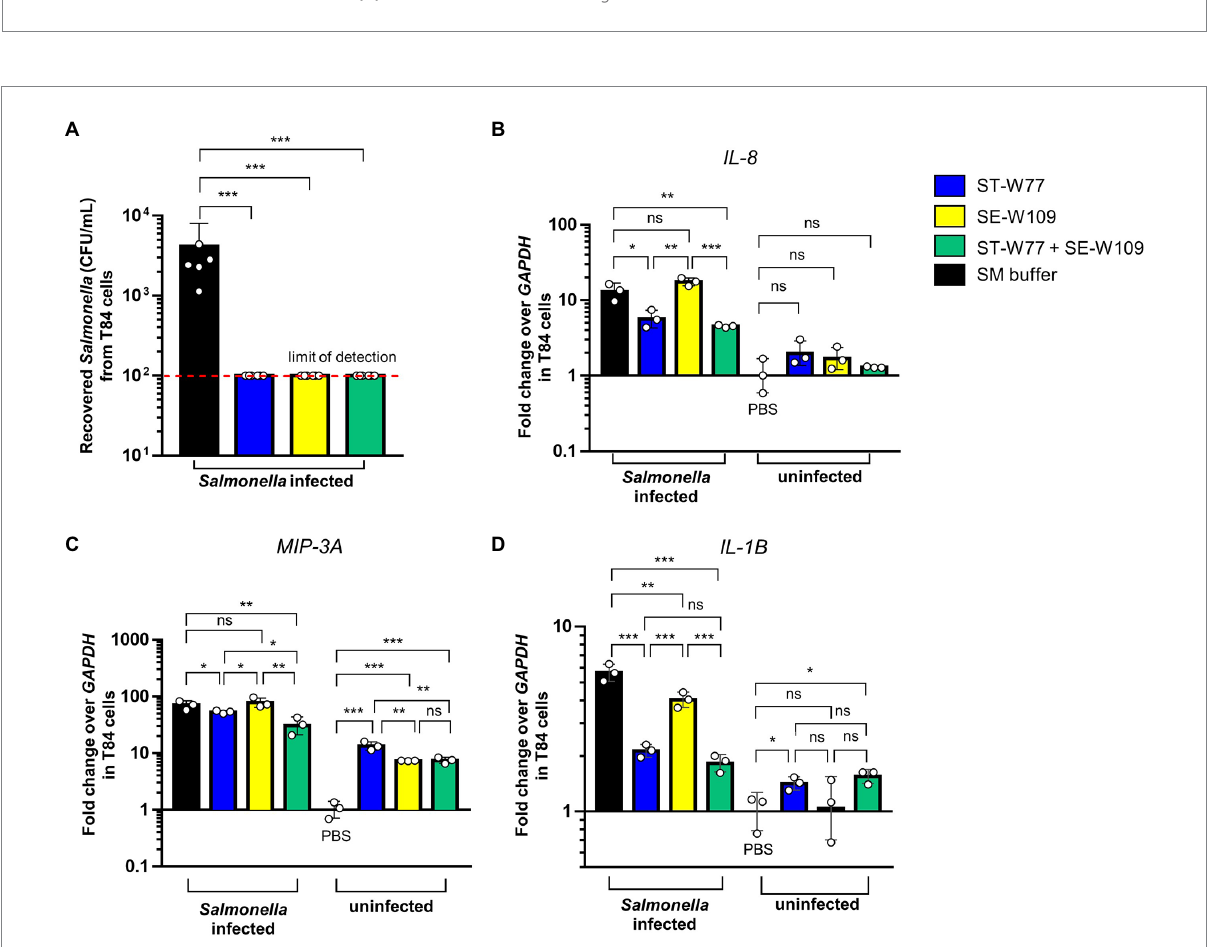
FIGURE 2 Efficiency of phages ST-W77 and SE-W109 in the protection against S. Tm invasion of human colonic epithelium. Human colonic epithelium (T84 cells) were seeded in a 24-well plate at a density of 10 5 cells/well. Each well was added 10 μ l of 5 × 10 10 PFU/mL phages or SM buffer for 5 min before S. Typhimurium infection (MOI = 25). After the gentamicin protection for 90 min, cells were lysed and recovered bacterial numbers (CFU/mL) were counted (A) . The invasion assay was repeated in a 6-well-plate with the same MOI to observe proinflammatory gene expressions. Fold change of gene expressions of human IL-8 (B) , MIP-3A (C) , and IL-1B (D) were determined by a qPCR using GAPDH as a housekeeping gene. Bars represent the geometric mean; error bars indicate geometric standard deviation. *, **, *** indicated p < 0.05, 0.01 and 0.001, respectively. ns, a non-statistically significant